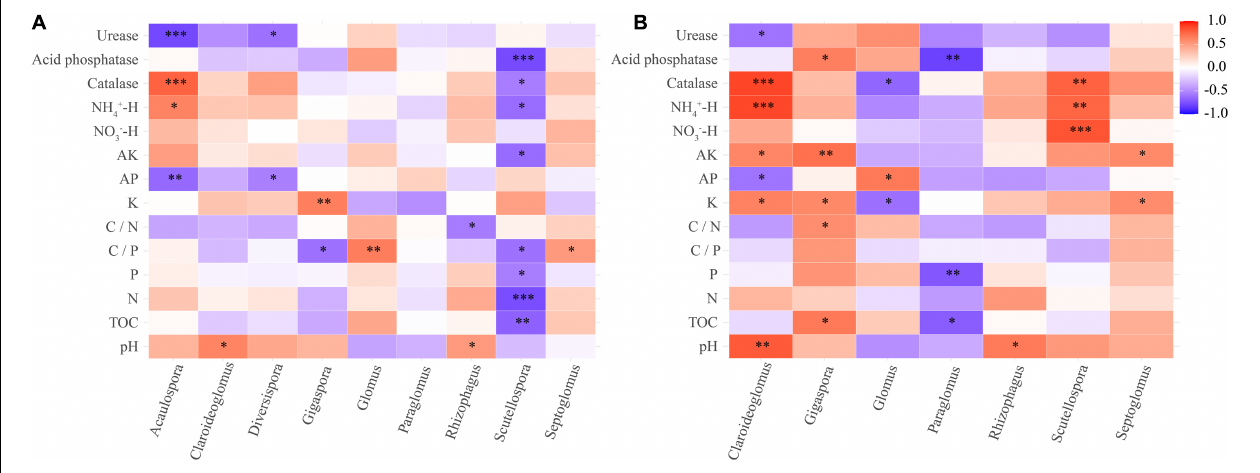
FIGURE 7 | Correlation heat map between soil chemical properties and AM fungal community (genus level) of rhizosphere soil (A) and root (B) of the teak plantations with different stand ages. ∗ p < 0.05; ∗∗ p < 0.01; ∗∗∗ p <